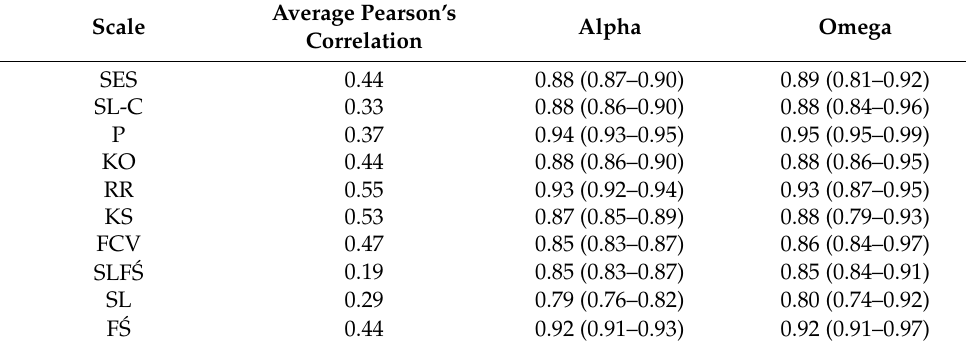
Table 1. Reliability analysis.